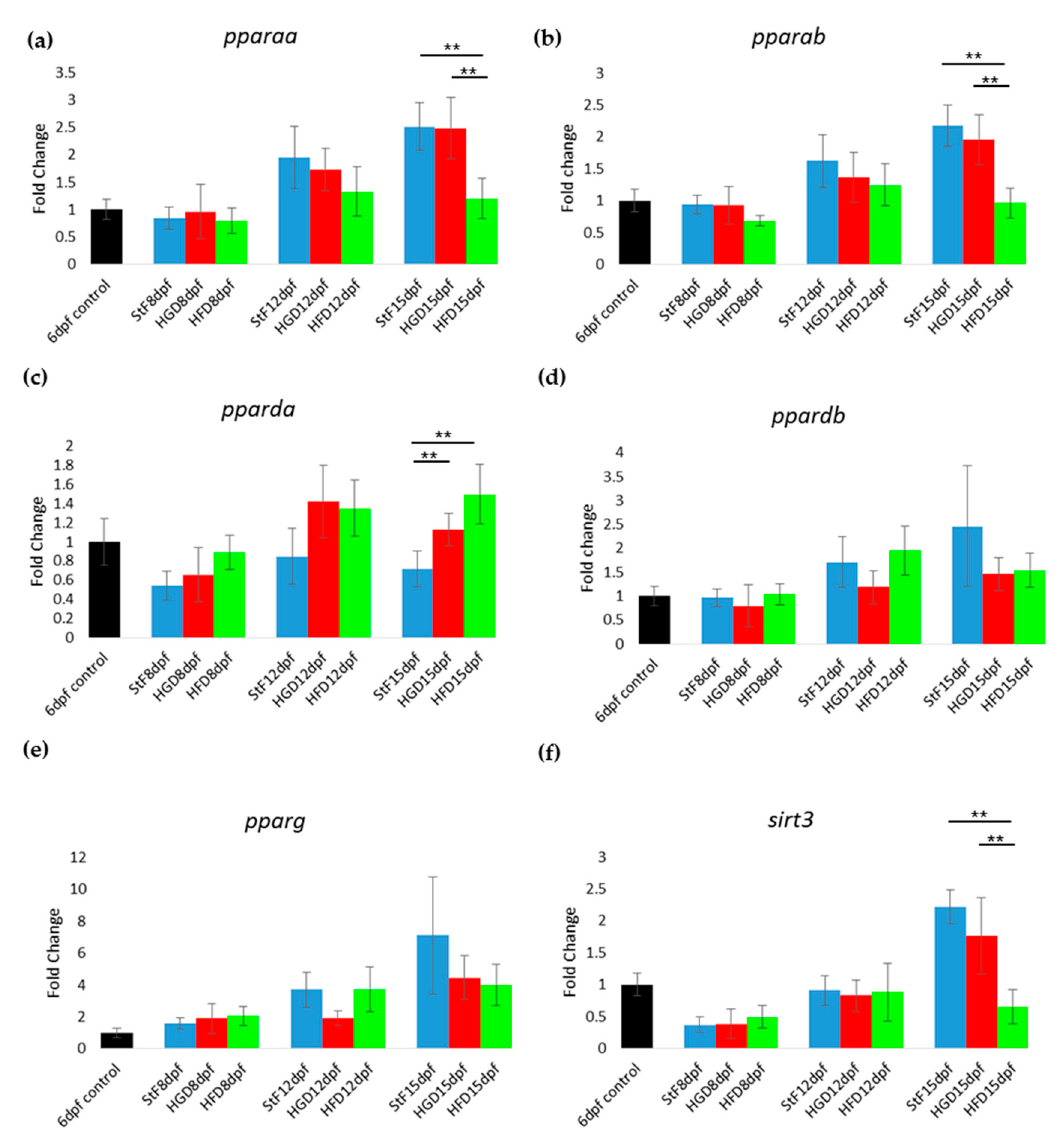
Figure 4. Gene expression of adipogenic markers during adipogenesis after exposure to different diets. ( a – f ) Fold change in expression at 8, 12 and 15 days, relative to mRNA sampled from embryos at 6 days post fertilization (6 dpf control). Larvae were fed with standard diet (StF), high glucose diet (HGD) or high fat diet (HFD) (** p ≤ 0.05) ( n = 4 (each sample contained 10 larvae)). Error bars represent SEM.